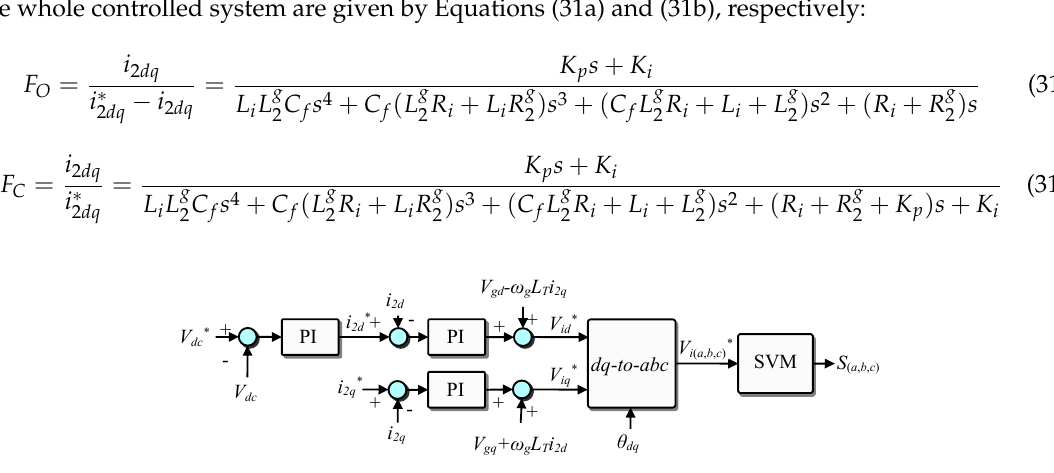
Figure 7. Voltage oriented PI control structure for LCL-filter-based Grid-connected Converters.